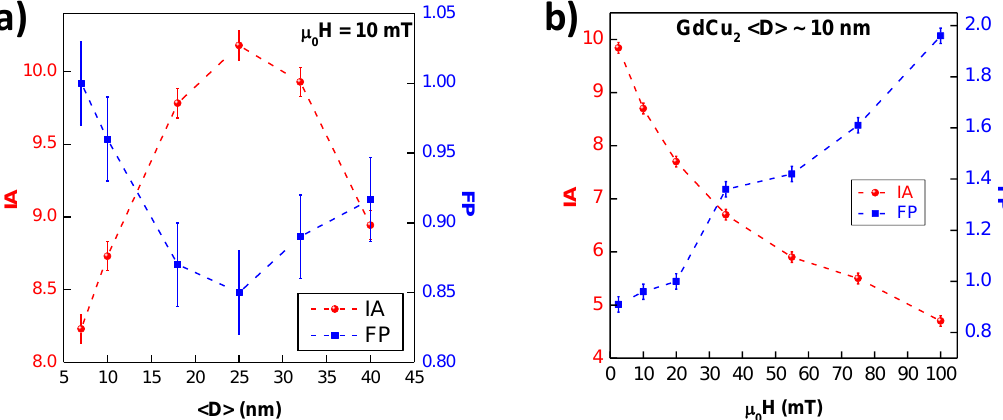
Figure 4. Evolution of the Irreversibility Area IA (red spheres) and the Spin Glass sharpness FP (blue squares) with respect to ( a ) mean diameter size for the different GdCu 2 NPs (the latter without error bars for clarity) and ( b ) µ 0 H for 10 nm-sized GdCu 2 NPs (2 h